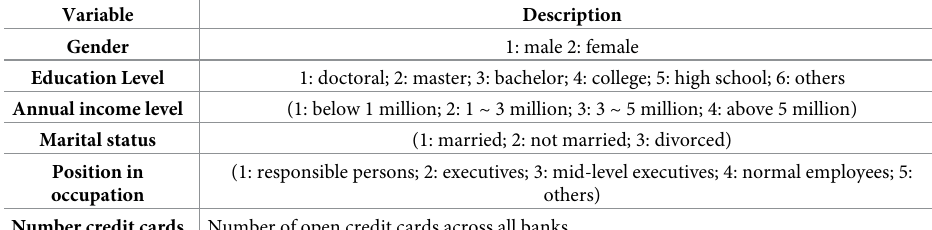
Table 6. Demographic based